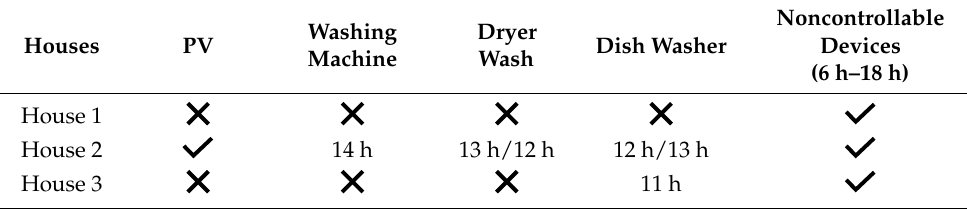
Table 5. Houses ’ final characteristics for Scenario 1. Table 5. Houses’ final characteristics for Scenario 1.